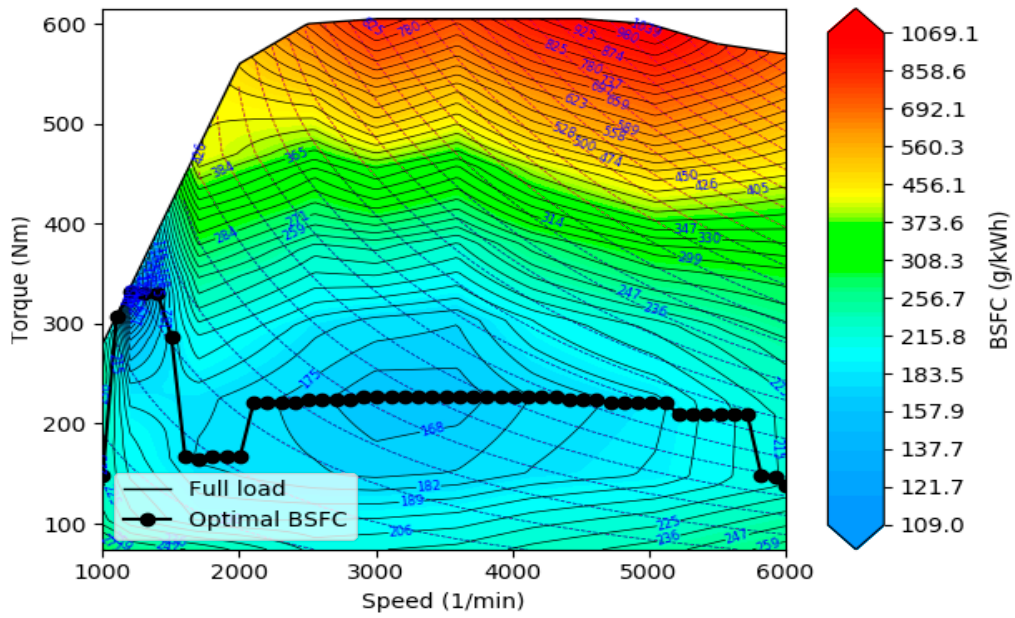
Figure 6. Map of brake specific fuel consumption of i.c.